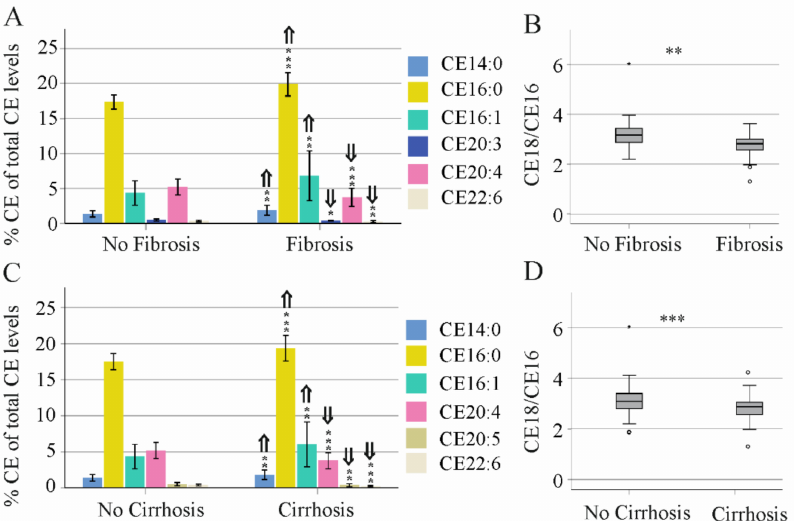
Figure 7. Proportion of cholesteryl ester (CE) species in relation to the FIB-4 score and to cirrhosis diagnosed by ultrasound. ( A ) % CE of total CE in patients with no fibrosis and patients with fibrosis defined by the FIB-4 score. ( B ) CE 18/CE 16 ratio in serum of these patients. ( C ) % CE of total CE in patients without and with liver cirrhosis diagnosed by ultrasound. ( D ) CE 18/CE 16 ratio in serum of these patients. * p < 0.05, ** p < 0.01, *** p < 0.001. ⇑ higher compared to no fibrosis/no cirrhosis, ⇓ lower compared to no fibrosis/no cirrhosis.